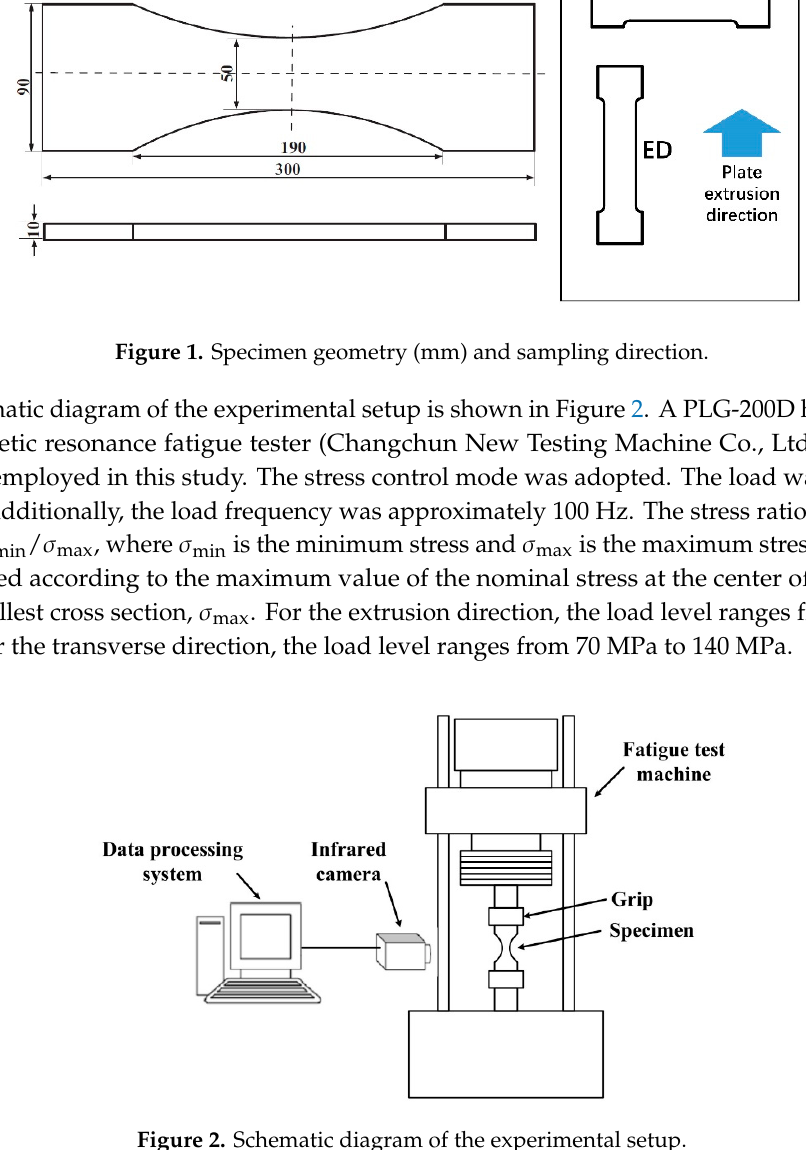
Figure 2. Schematic diagram of the experimental setup.